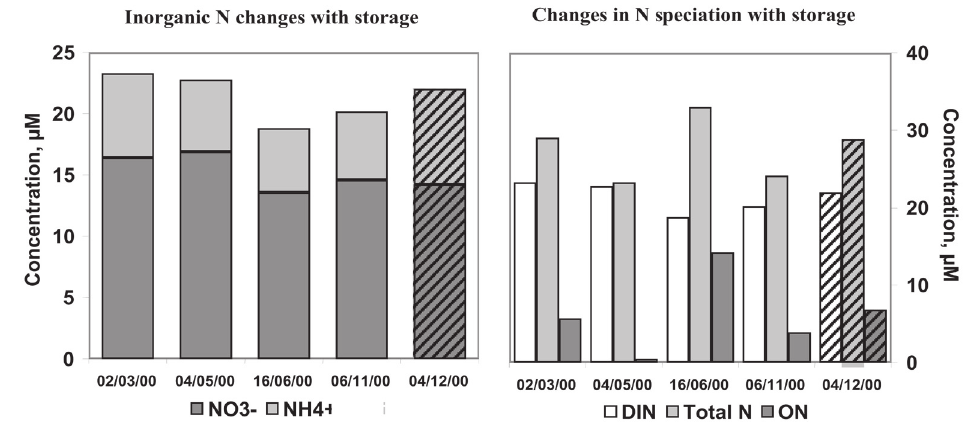
FIGURE 3. Effect of strage of 9 months at 4ºC on N content of a rain